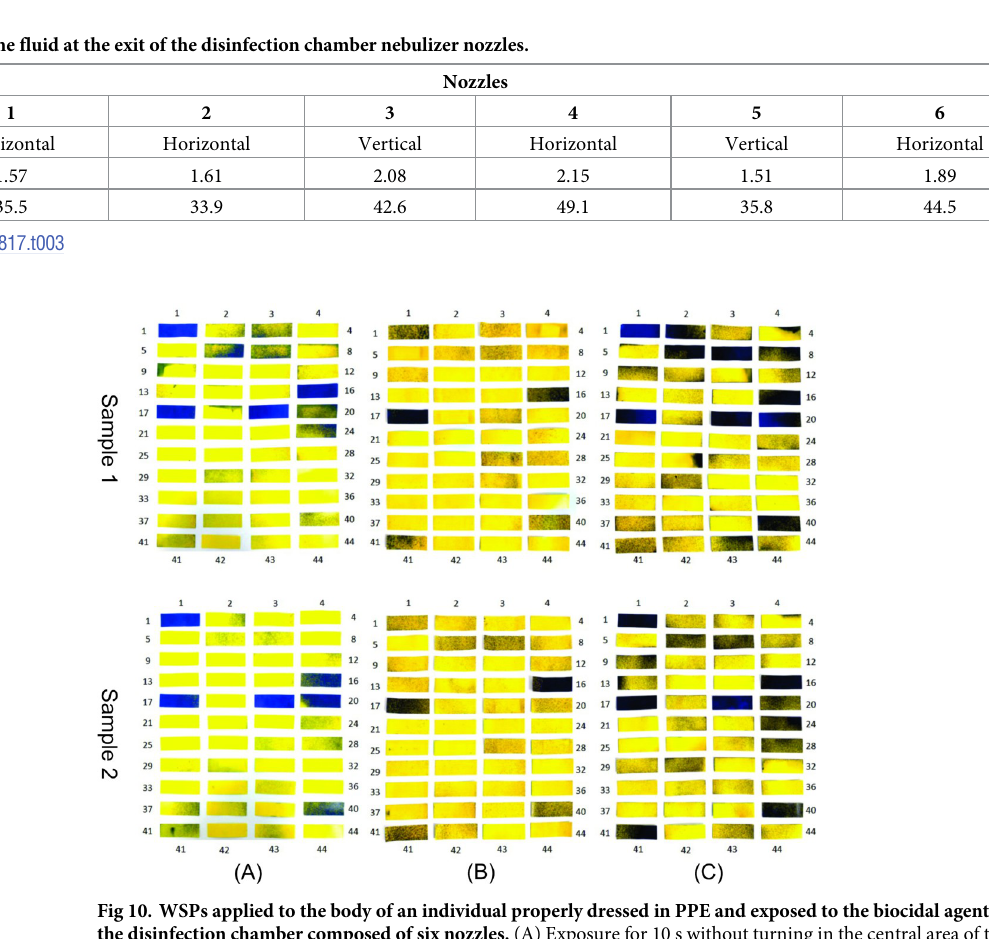
PLOS ONE | https://doi.org/10.1371/journal.pone.0251817 May 19,